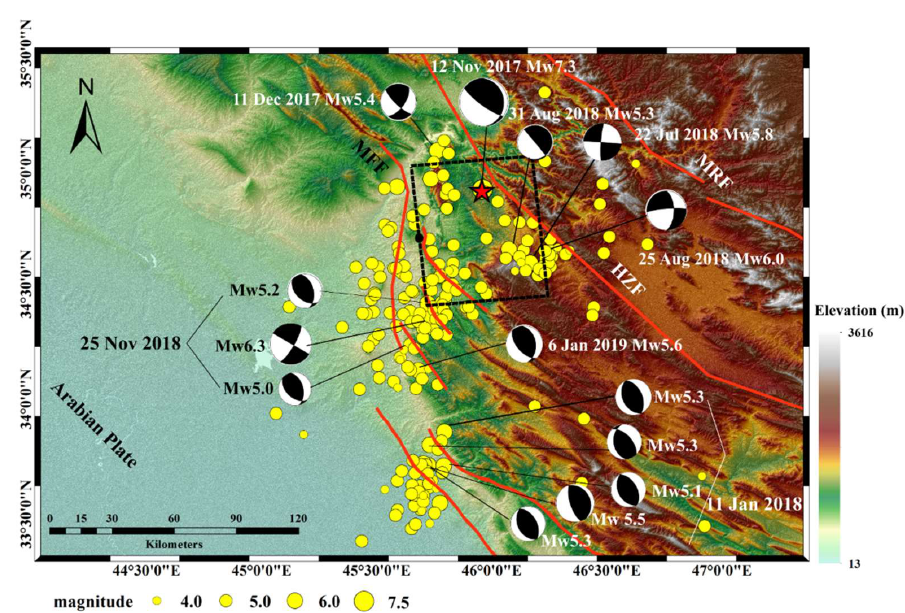
Figure 1. Map of the study area. The red star represents the location of the mainshock (from USGS earthquake Catalog). The black dashed rectangle marks the coseismic fault [3]. The black dot indicates the upper edge of fault. The red lines are nearby faults (MRF: the Zagros Main Recent Fault, HZF: the High Zagros Fault, MFF: the Zagros Mountain Front Fault). Yellow circles mark aftershocks (Mw > 3.0) up to 839 days after the mainshock (from USGS earthquake catalog: https: // earthquake.usgs.gov / earthquakes /